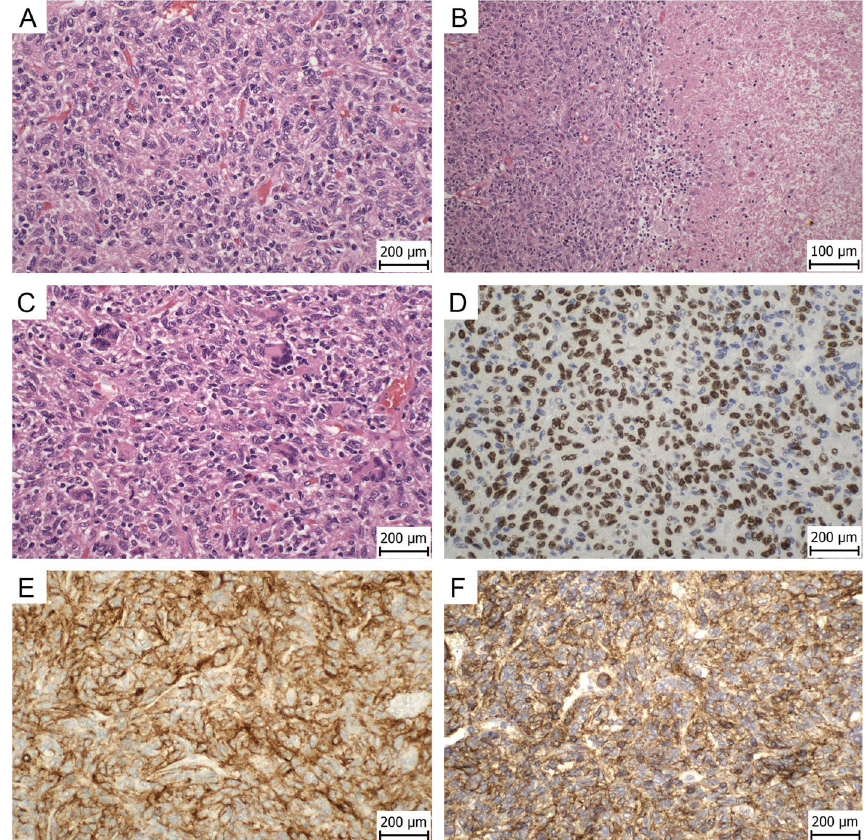
Fig. 1 Hematoxylin–eosin staining showing tumor consisted of epithelioid to spindled cells with mild-to-moderate nuclear atypia, finely granular or vesicular chromatin, and small nucleoli (400x) A . In the tumor there were small foci of necrosis (200x) B . High-power view showed scattered large multinucleated giant cells (400x) C . Immunohistochemically, the tumor showed diffuse expression of TFE3 D , CD10 ( E ), and IFITM1 ( F )